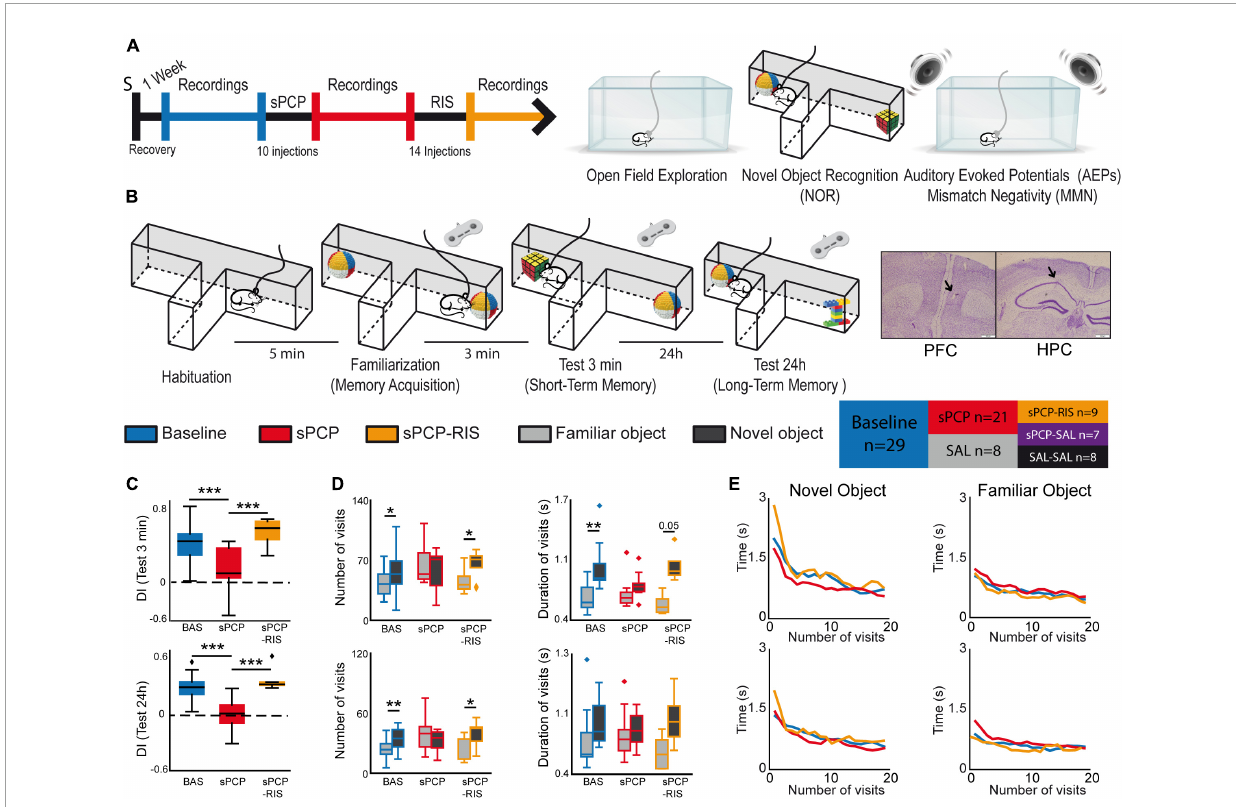
FIGURE1 Experimental design and main behavioral results. (A) Experimental protocol and behavioral tests used. S indicates the date of surgery to implant recording electrodes. (B) The novel object recognition test (NOR) in detail. Right and left buttons on a joystick were pressed for the duration of each visit to timestamp the information into the recording files. Representative examples of histological verification of electrode locations within the prelimbic PFC and the CA1 area of the HPC. We recorded neural activities during the surgical implantations to increase the chances of implanting the electrodes within the target areas. At the end of the experiment, before euthanasia, a gentle current was passed through the electrodes to mark the recording areas (arrows). Also shown is a summary table that illustrates the different pharmacological groups of the study and the number of mice used in each group. (C) Discrimination indices (DIs) during the 3-min (STM) and the 24 h (LTM) tests. DIs decreased significantly after sPCP and recovered after chronic risperidone (STM, LTM: F ( 2 , 6 ) = 16.64, 15.15, p = 0.004, < 0.0005; one-way repeated measures ANOVA, n = 9 mice; the results including all the mice are shown in Supplementary Figure 1 ). (D) Number and mean duration of visits to familiar and novel objects during the STM and LTM tests. After sPCP, mice visited both objects evenly by increasing the number of visits to familiar objects, reflecting poor recognition memory ( F ( 1 , 13 ) = 15.12, 5.2, p = 0.002, 0.037). (E) The duration of the visits decreased within a session as the mice became less interested in the objects ([baseline STM, LTM]: F ( 2 , 26 ) = 3.52, 3.56, p = 0.005, 0.0006; one-way repeated measures ANOVA with novel and familiar objects combined). A sharp decrease in duration occurred during the first 5 visits to both objects in the two tests, and this was more pronounced for novel objects (first 5 visits to novel objects vs. first 5 visits to familiar objects; [STM, LTM]: F ( 2 , 26 ) = 36.03, 11.57, p < 0.0005, 0.002). These behaviors were not